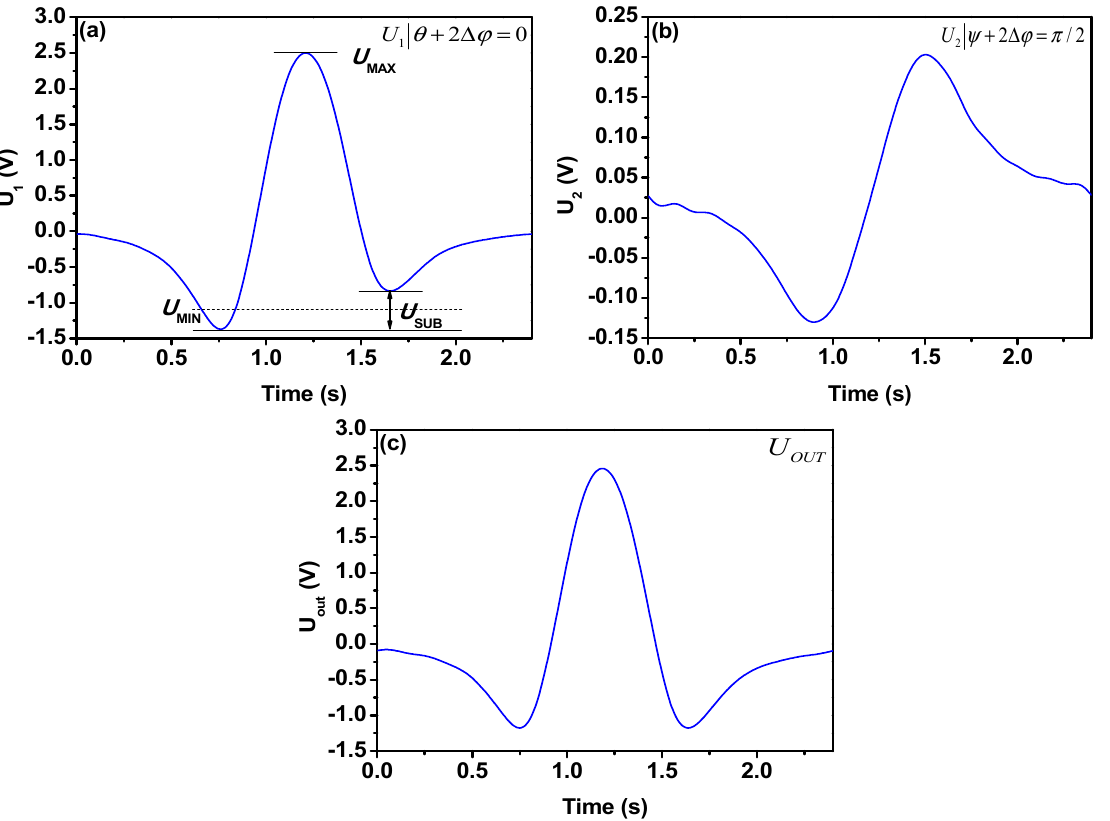
Figure 3. ( a ) Second harmonic signal output from lock-in amplifier 1, ( b ) The RAM components output from lock-in amplifier 2, ( c ) The second harmonic signals after applying the dual path lock-in technique, the RAM effects are totally eliminated.